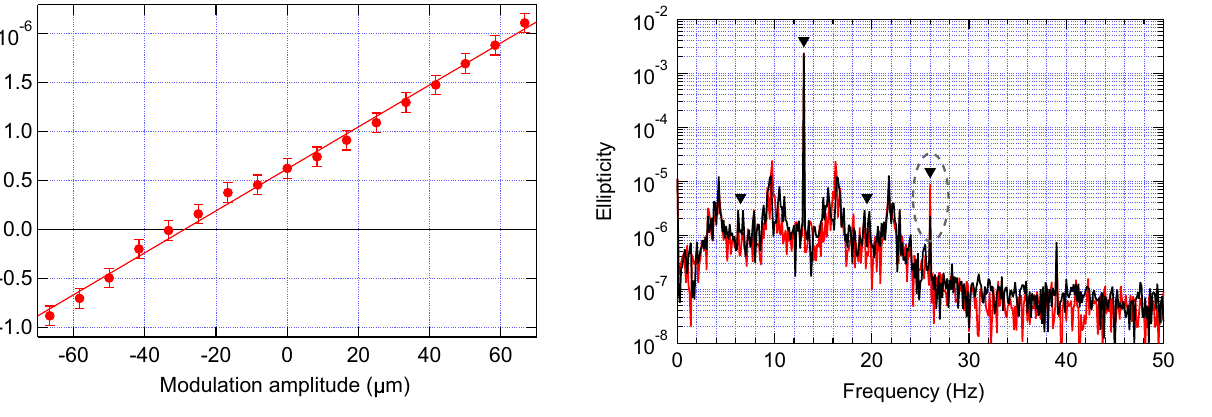
Fig. 8 Induced ellipticity 4 ν P as a function of the modulation ampli- Fig. 9 Cotton–Mouton ellipticity spectrum of air obtained with the tude of the rotation axis at ν P = 6 . 5 Hz (with the phase φ 1 , 0 set for rotating wave plates polarimeter. The two spectra have been recorded maximum ellipticity) for the zero-wave CWP assembly. Superimposed with the magnetic fields of the two stationary dipole magnets oriented / r φ ≈ 2 × 10 − 8 µ m − 1 is a linear fit indicating a slope ψ 4 ν parallel (red) and orthogonal (black) to each other. A uniform window P 1 , 0 and 10 vector averages lasting 8 s each have been